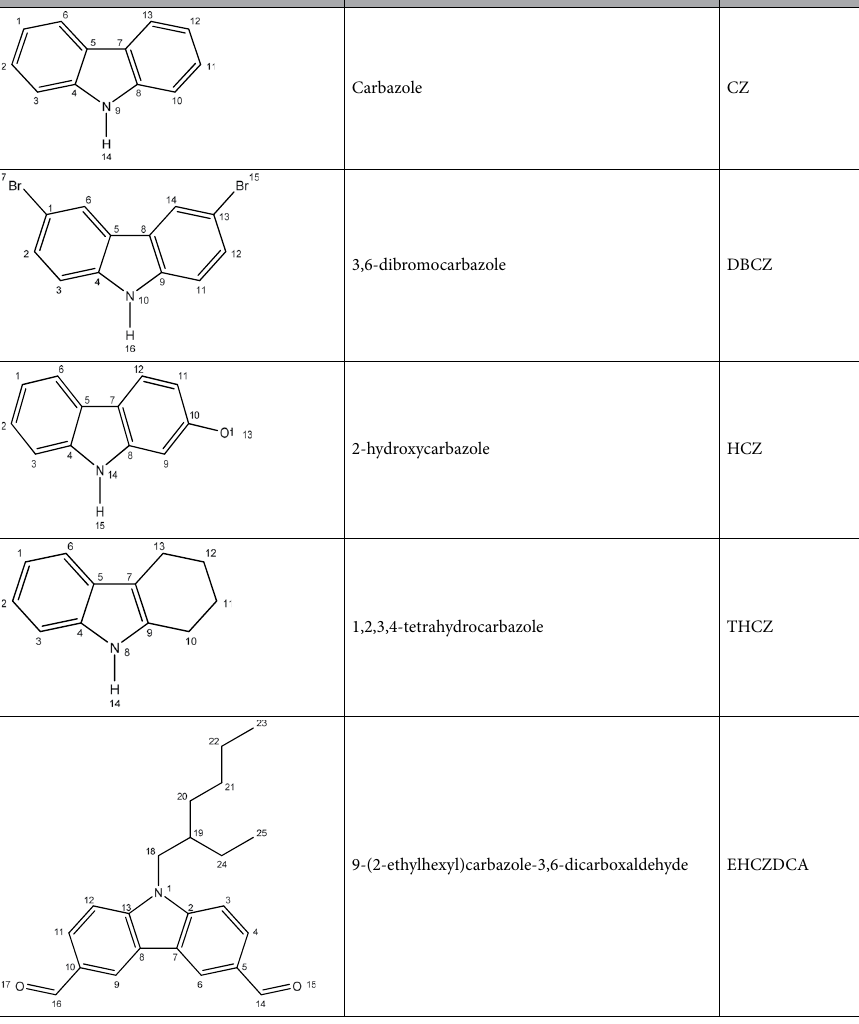
Table 1. Molecular structures, IUPAC names and abbreviations of the studied